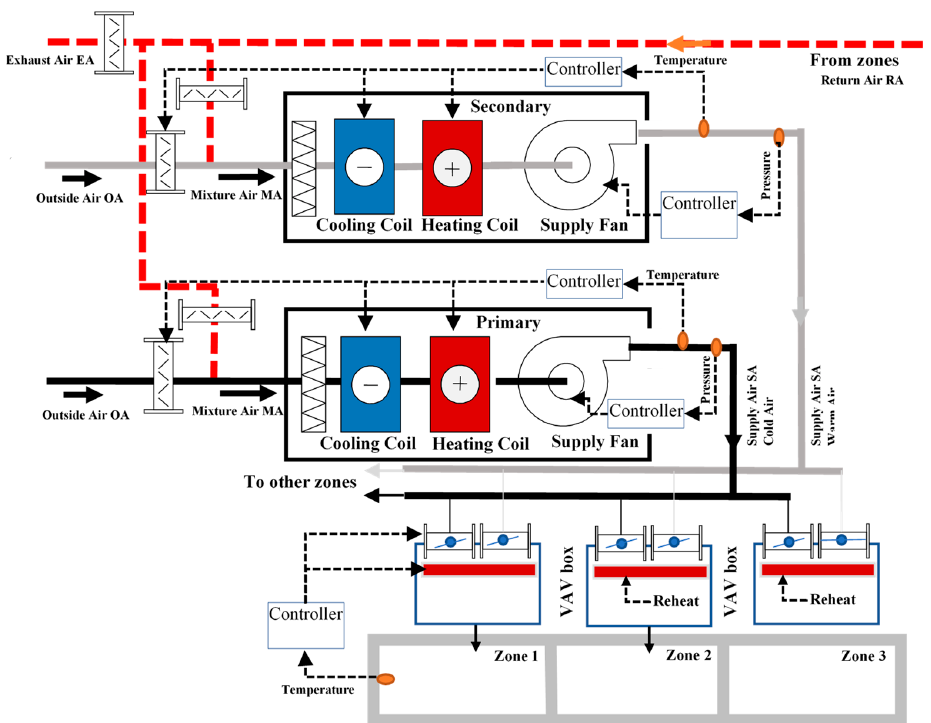
Figure 2. Proposed dual VAV system configuration [9].